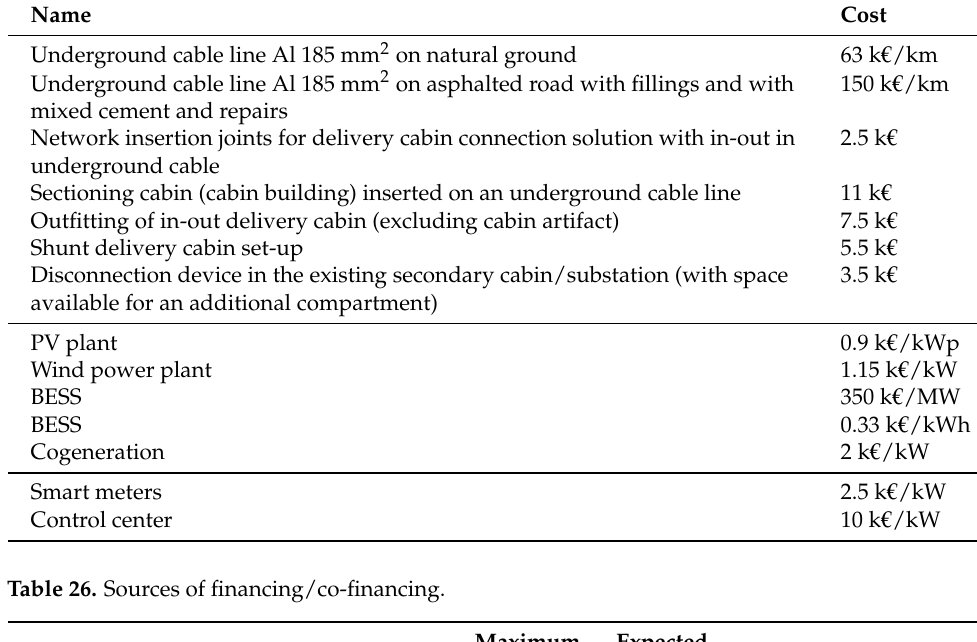
Table 25. Unit costs for plants.